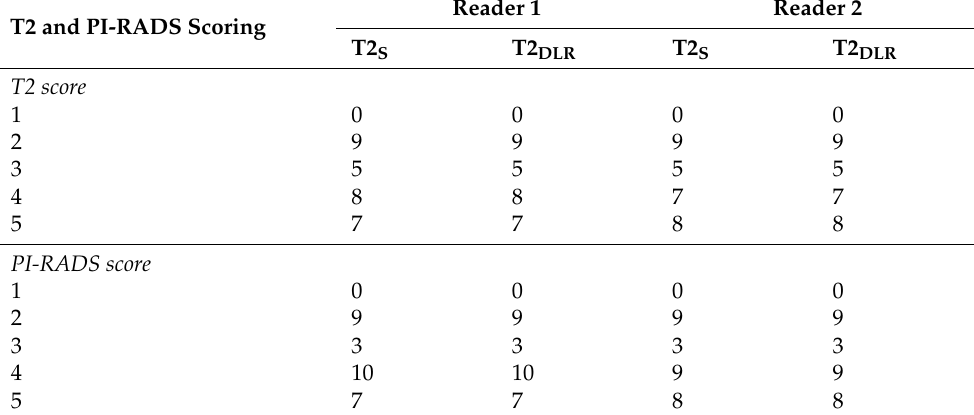
Table 4. T2 and PI-RADS scoring (29 cases).